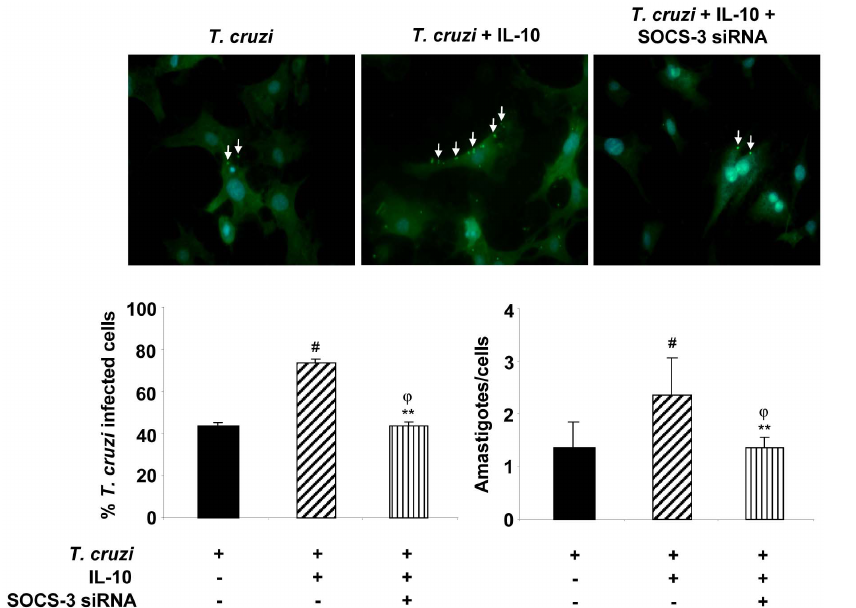
Figure 7. SOCS-3 silencing reverts IL-10-induced cardiomyocytes parasitism. Cells grown on glass coverslips were infected, infected and treated with 20 ng/ml of IL-10 or silenced by siRNA for 72 h and then pre-treated with IL-10 and infected for 48 h. Infected cells were incubated with rabbit polyclonal serum against to T. cruzi followed by FITC-labeled goat anti-rabbit IgG. Afterwards, cells were counterstained with DAPI (300 nM). The percentage of infected cells (left bar graph) and the number of amastigotes/cell (right bar graph) are shown. Results represent the Mean 6 SD of two experiments. Microphotographs are representative of 30 fields taken at 400X magnification. White arrows show FITC-anti- T.cruzi- labelled intracellular amastigotes.